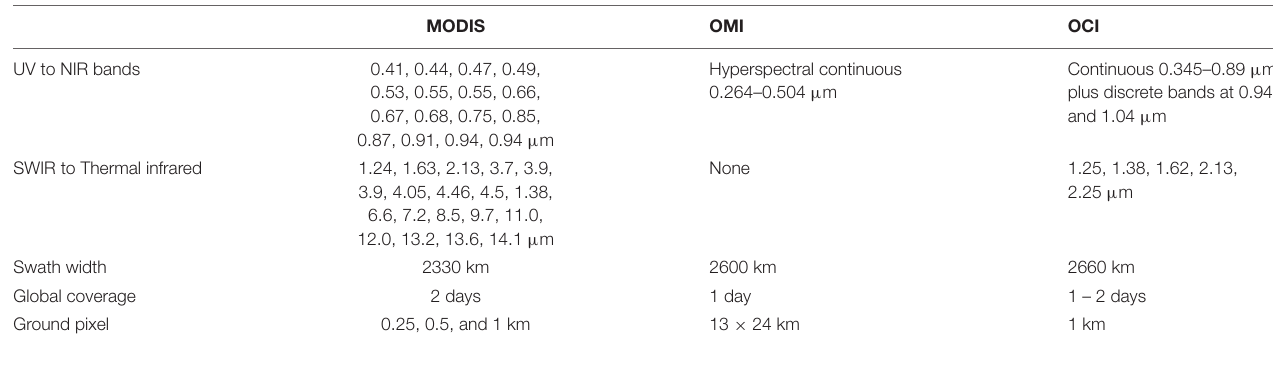
TABLE 1 | Instrument specifications for MODIS, OMI, and